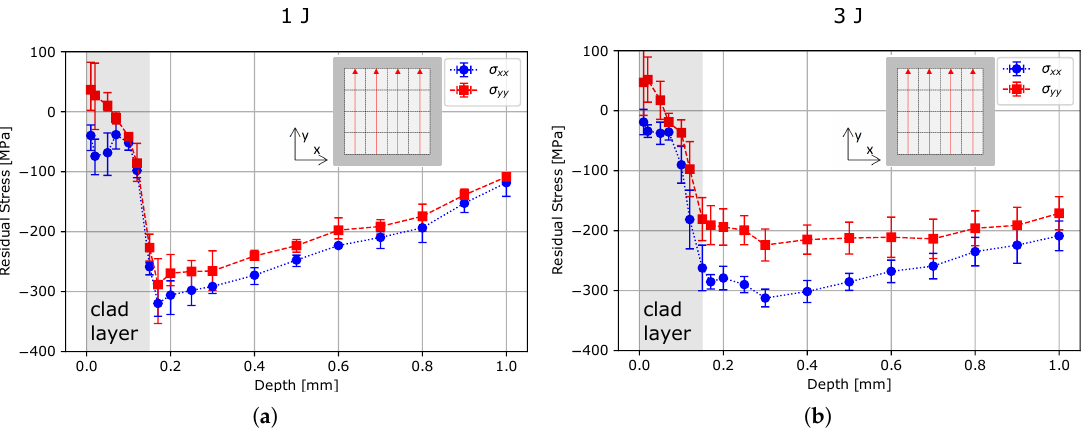
Figure 11. Residual stress profiles for AA2024-T3clad specimens with the advancing direction chosen orthogonal to the rolling direction: ( a ) 1 J and ( b ) 3 J. The gray area indicates the clad